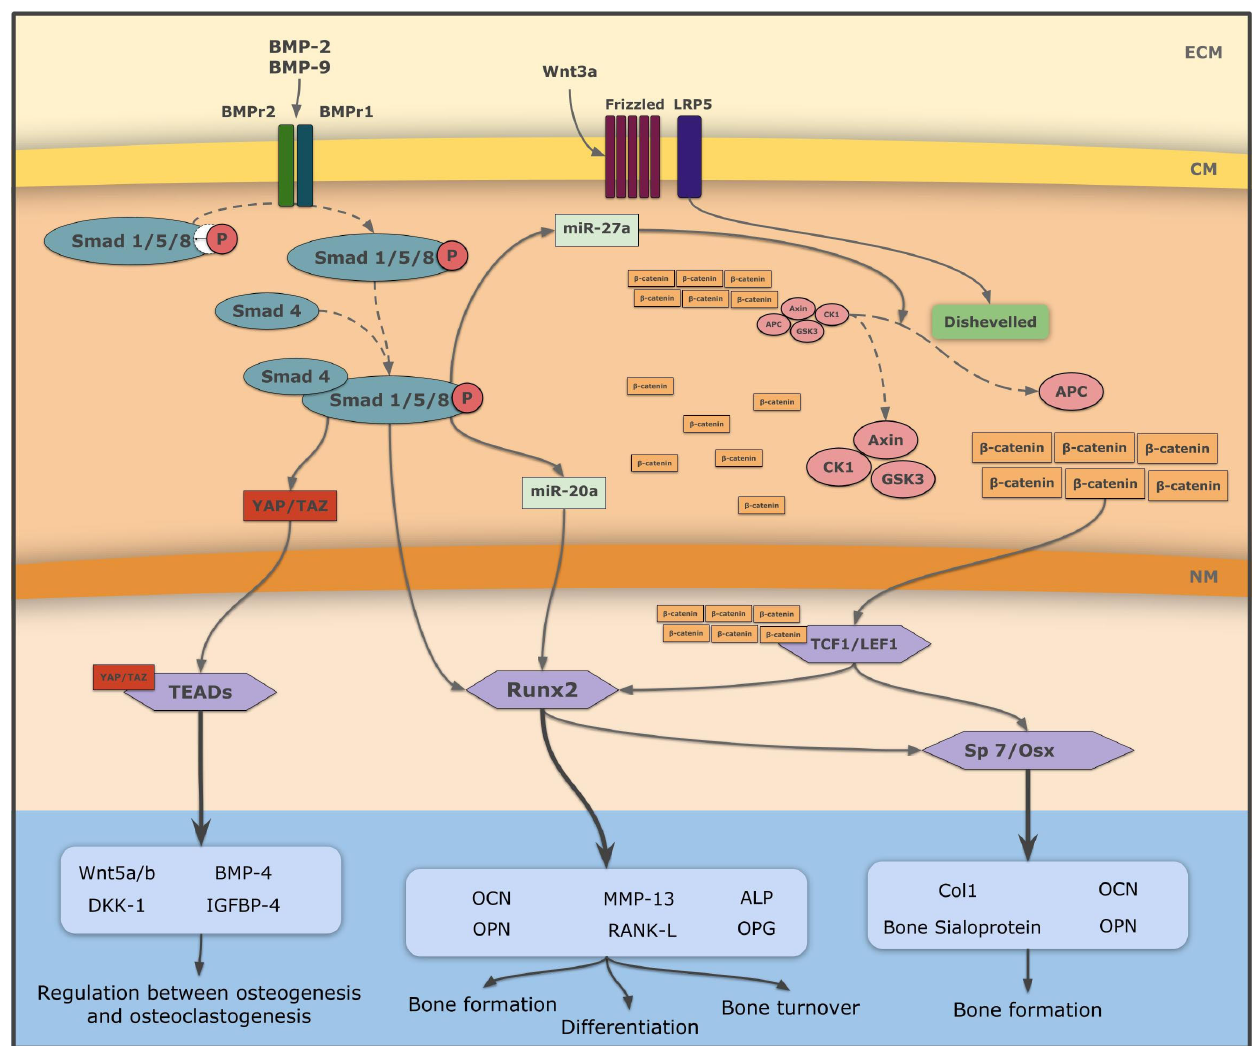
Figure 1. A brief summary of BMP ‐ 2 and BMP ‐ 9 signaling pathways, and their relation to the Wnt canonical pathway. ECM, extracellular matrix; CM, cell membrane; NM, nuclear membrane; BMP ‐ 2, bone morphogenetic protein 2; BMP ‐ 4, bone morphogenetic protein 4; BMP ‐ 9, bone morphogenetic protein 9; BMPr2, bone morphogenetic protein 2 receptor; BMPr1, bone morphogenetic protein 1 receptor; miR, microRNA; miR ‐ 27a, microRNA 27a; miR20a, microRNA 20a; Wnt3A, Wnt family member 3A; Wnt5a/b, Wnt family member 5a and 5b; DKK ‐ 1, Dickkopf ‐ related protein 1; LRP5, low ‐ density lipoprotein receptor ‐ related protein 5; YAP, yes ‐ associated protein; TAZ, transcriptional co ‐ activator with PDZ ‐ binding motif; APC, activated protein C; GSK3, glycogen synthase kinase ‐ 3; CK1, casein kinase 1; TEADs, transcriptional enhancer cific T ‐ cell factor/factor 1 transcriptional factor; MMP13, matrix metallopeptidase 13; RANK ‐ L, receptor activator for nu